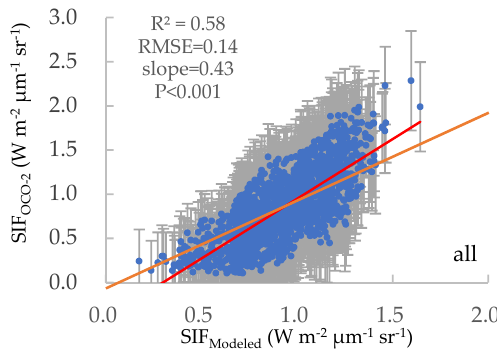
Figure 12. Scatter plots between OCO-2 observed and EVI-simulated SIF in 2018. The red line indicates the regression line, and the orange line indicates the 1:1 line.